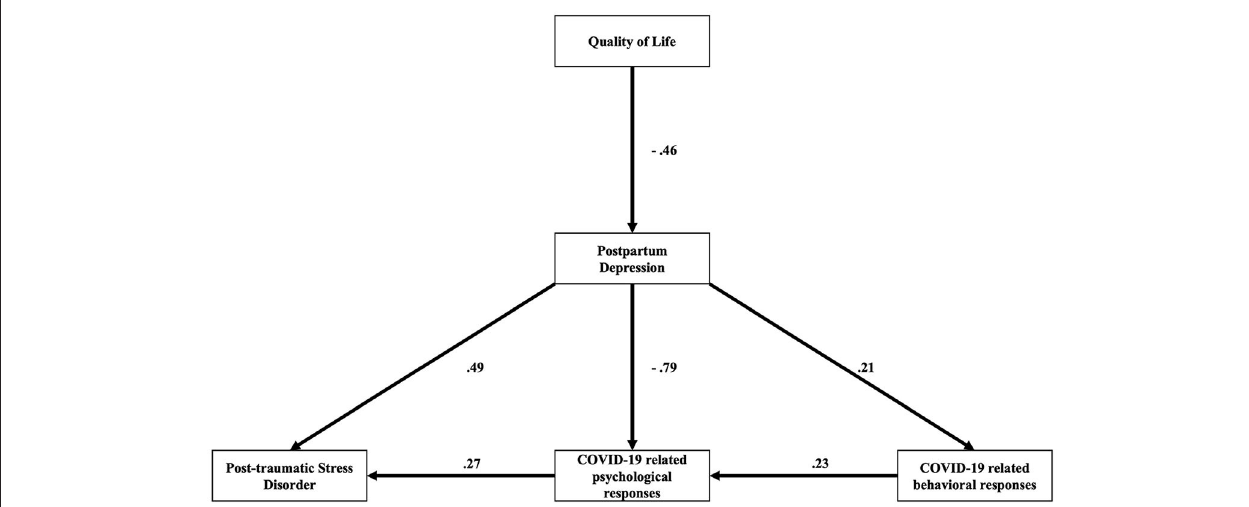
FIGURE 1 | The hypothesized model relating the scores of PCL-6, EPDS, and COVID-9-related psychological and behavioral. All path loadings were significant ( p < 0.05).